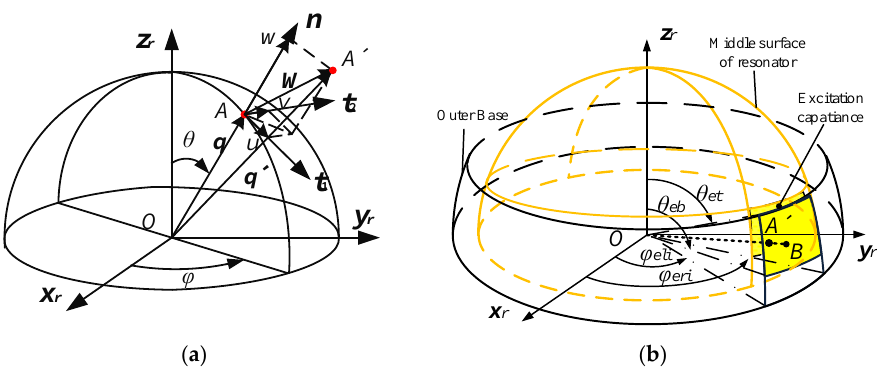
Figure 4. Structure diagram of the resonator: ( a ) The deformation of the resonator; ( b ) The excitation capacitance driving the resonator.